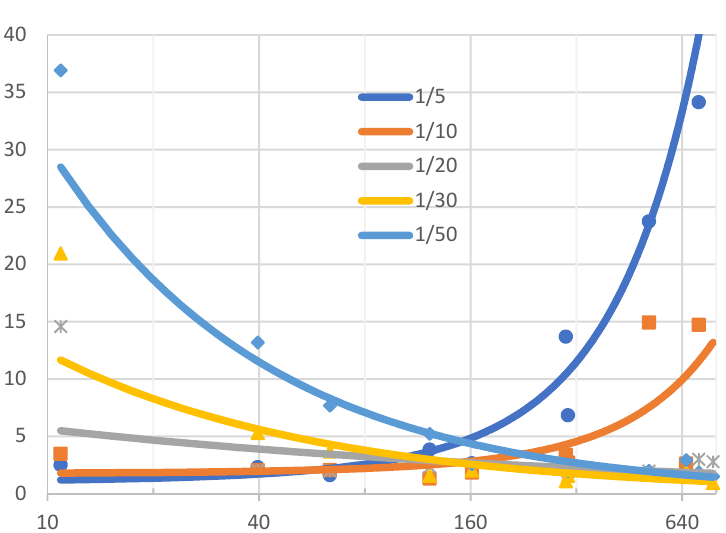
Figure 13. The results of the calculation of the measurement uncertainty for different exposure times and the speed of the marker movement.